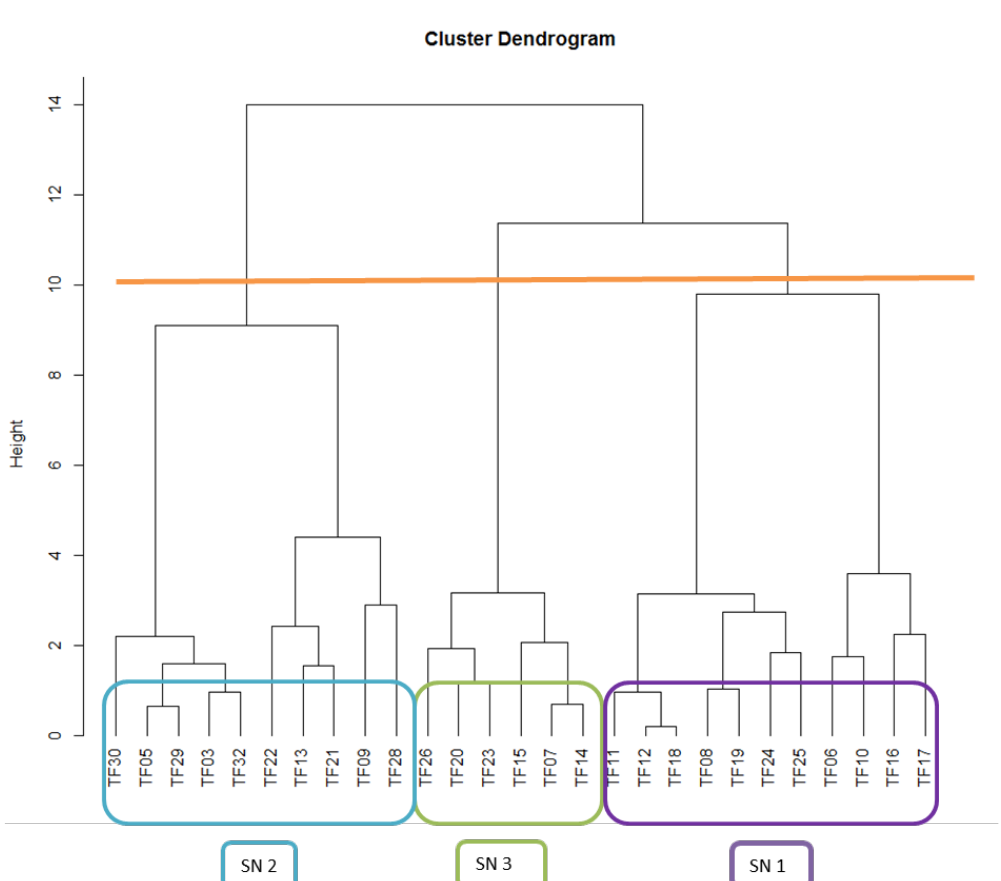
Figure A1.2 Cluster Dendrogram obtained from the AHC on the scores of famers on the axes of the multivariate analysis on semi-natural areas management